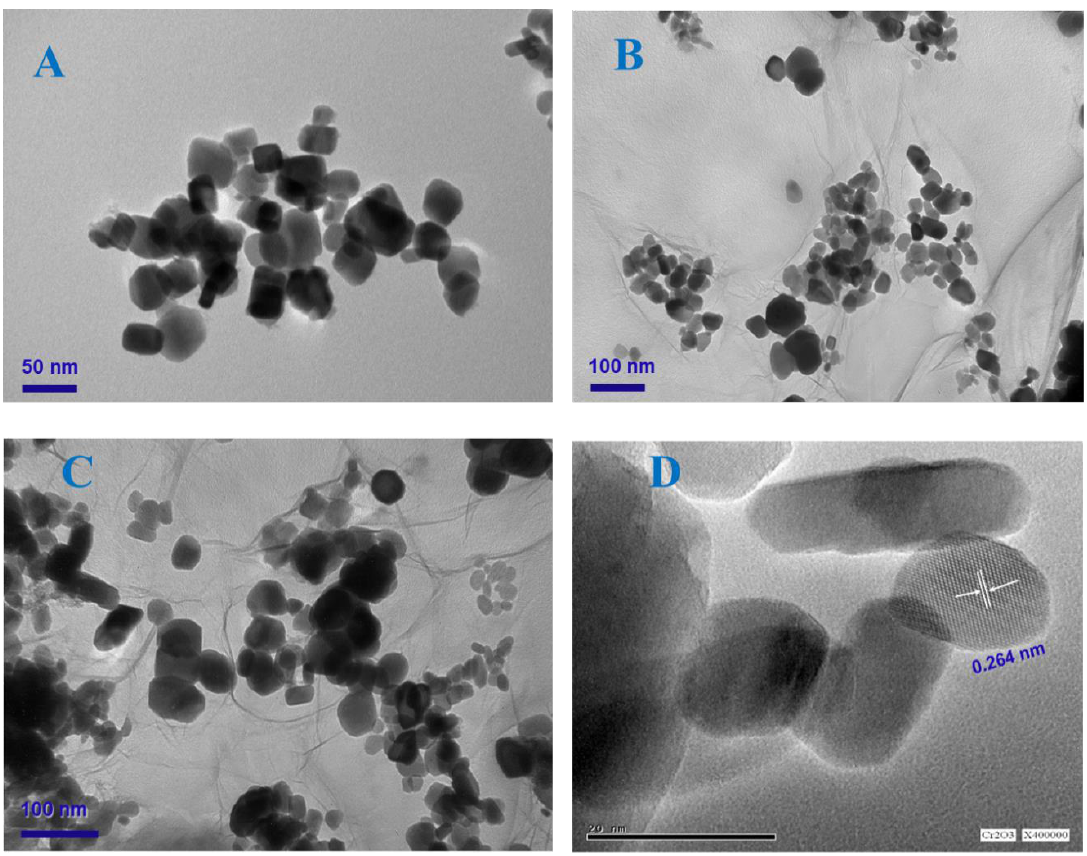
Figure 4. TEM micrographs obtained for Cr 2 O 3 NPs ( A ) Cr 2 O 3 /rGO ( B ) and Cr 2 O 3 / GO ( C ) hybrids. The panel (D) shows HRTEM micrograph obtained for Cr 2 O 3 .